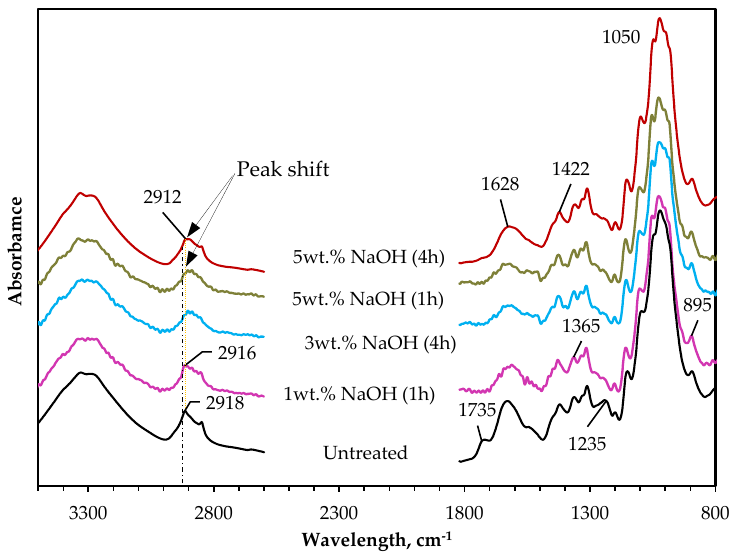
Figure 6. Average vertically shifted spectra of untreated and NaOH pretreated (1 wt.%, 3 wt.%; 5 wt.%) hemp fibers.